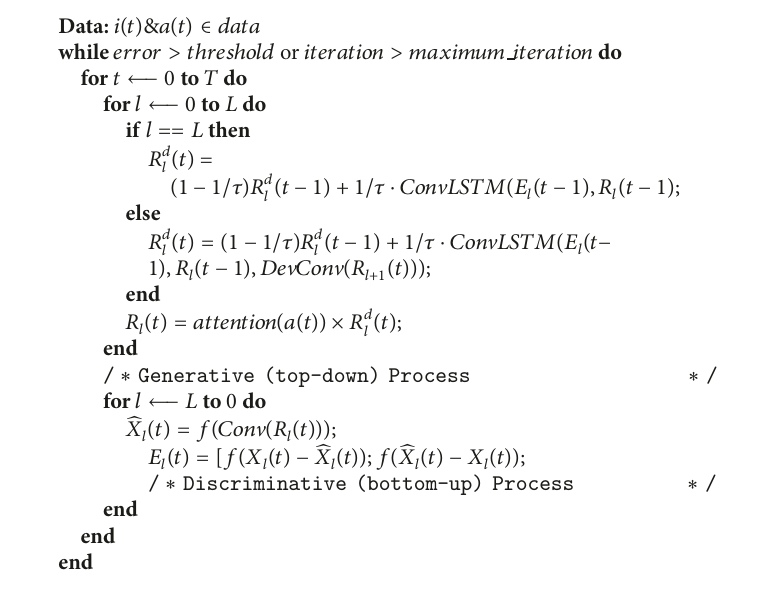
Algorithm 1: MT-AFA-PredNet Computation.